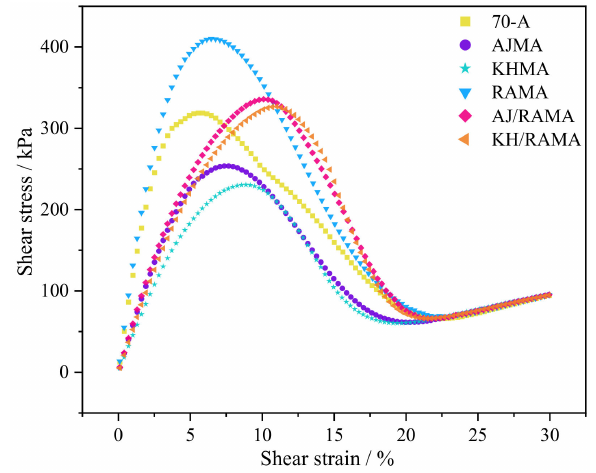
Figure 9. Stress-strain